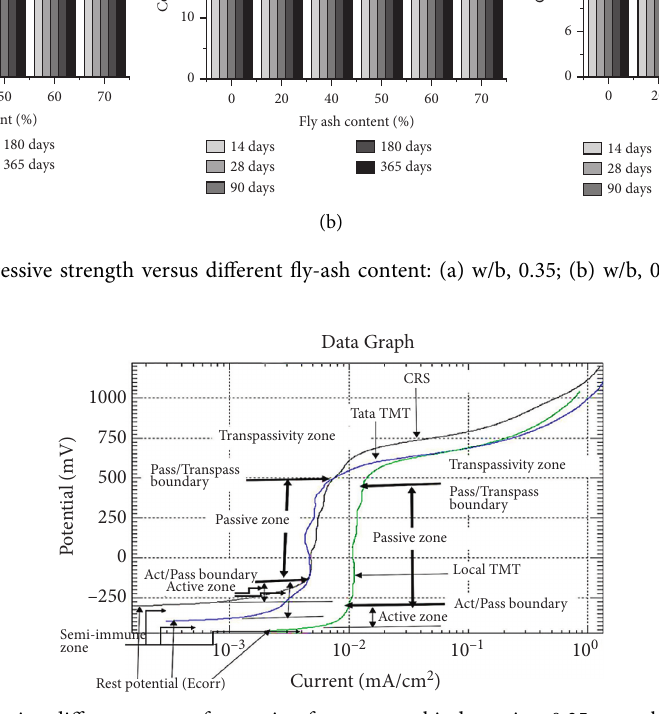
Figure 4: Polarization curve showing different zones of corrosion for water-to-binder ratio � 0.35, uncarbonated concrete containing 50% fly